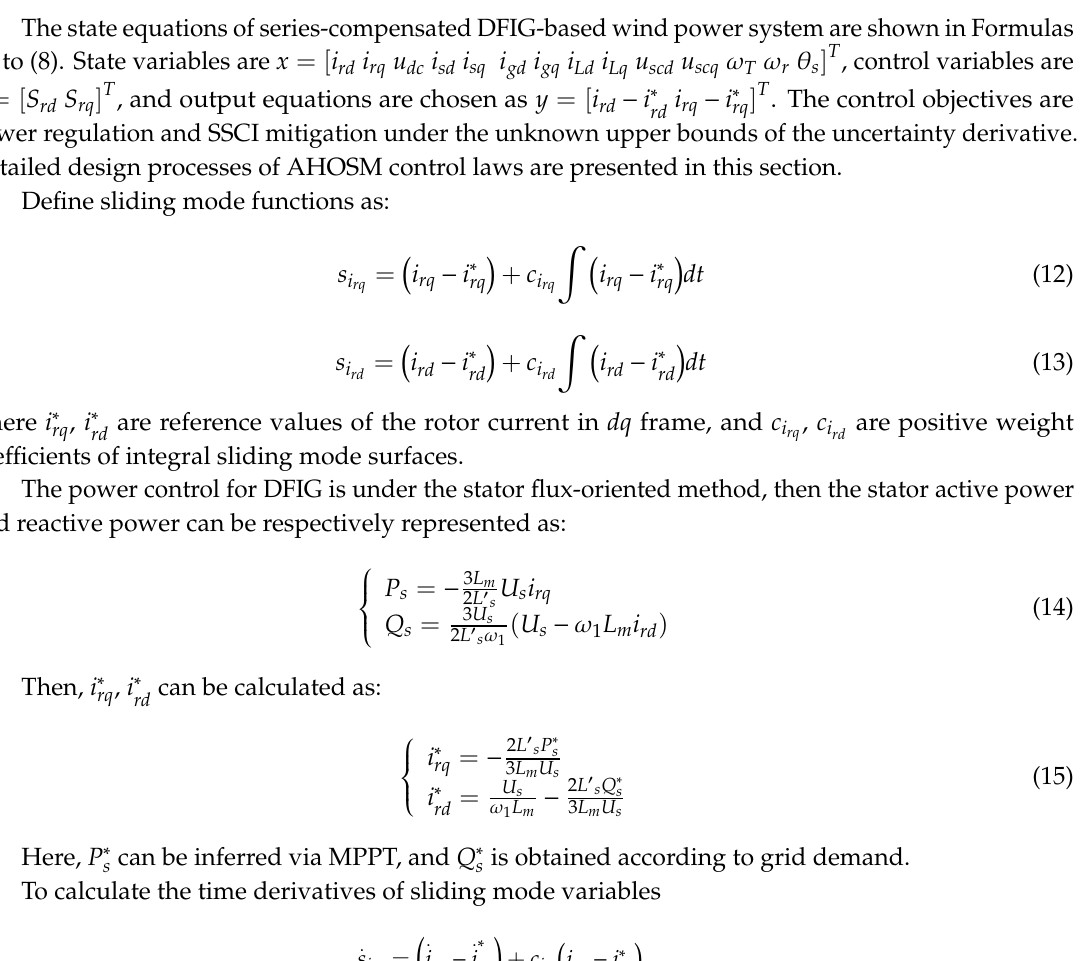
Figure 2. Schematic diagram of the generation process of sub-synchronous control interaction (SSCI).